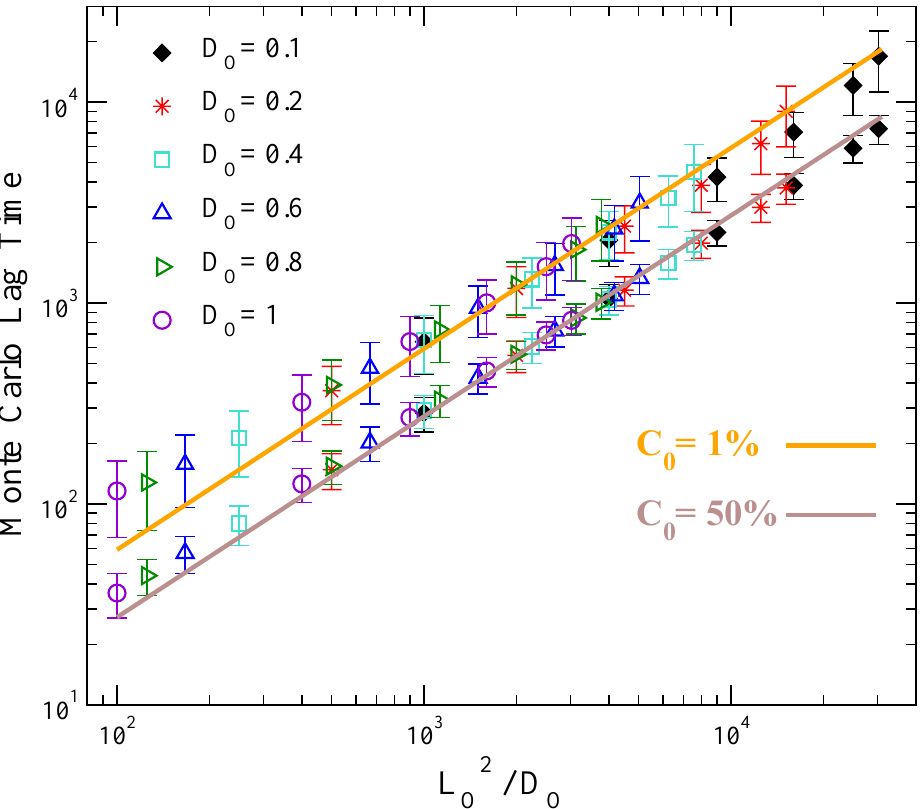
Figure 6. Numerical results of the lag times obtained by Monte Carlo simulations as a function of L 2 /D O , for two different initial drug loadings C 0 = 0.01 (upper group of points) and C 0 = 0.5 (lower group of points). Thirty-six data points are shown in each case and the different symbols correspond to different values of D O according to the labelling. Lag times have been averaged over 500 Monte Carlo realizations. Error bars represent standard deviations. Solid lines represent linear fittings of the corresponding data.